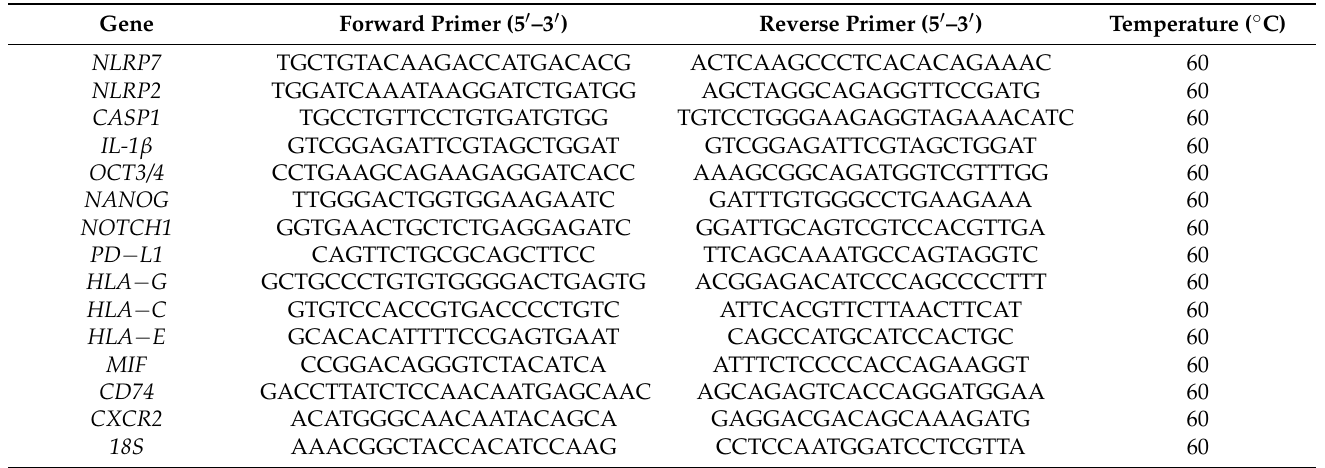
Table 1. Primers used for real-time